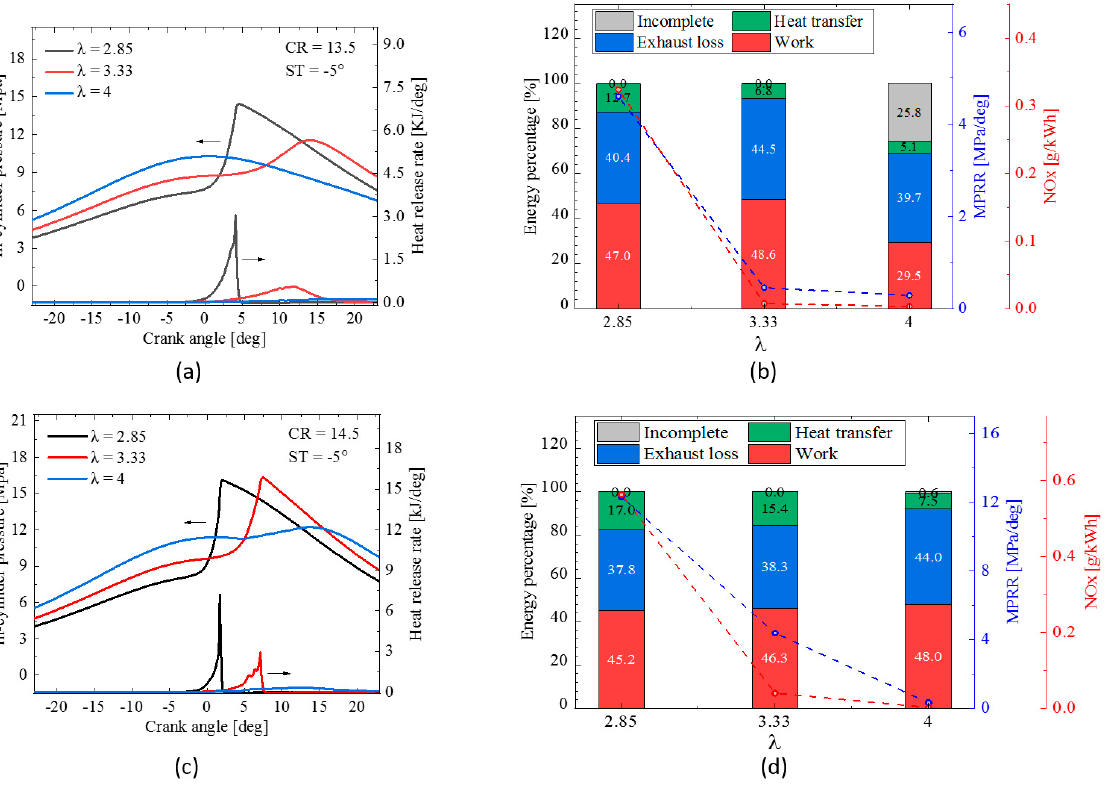
Figure 10. Comparison of: ( a ) pressure and heat release rate traces; ( b ) efficiency for CR = 13.5; ( c ) pressure trace and heat release rate; and ( d ) efficiency for CR = 14.5 using different λ at ST = − 5 CAD.